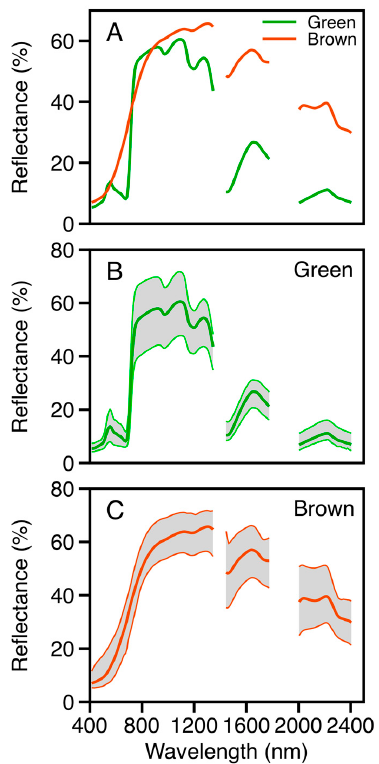
Figure 3. ( A ) Comparison of mean green and brown leaf reflectance, followed by mean, minimum and maximum reflectance values for ( B ) green and ( C ) brown foliage.